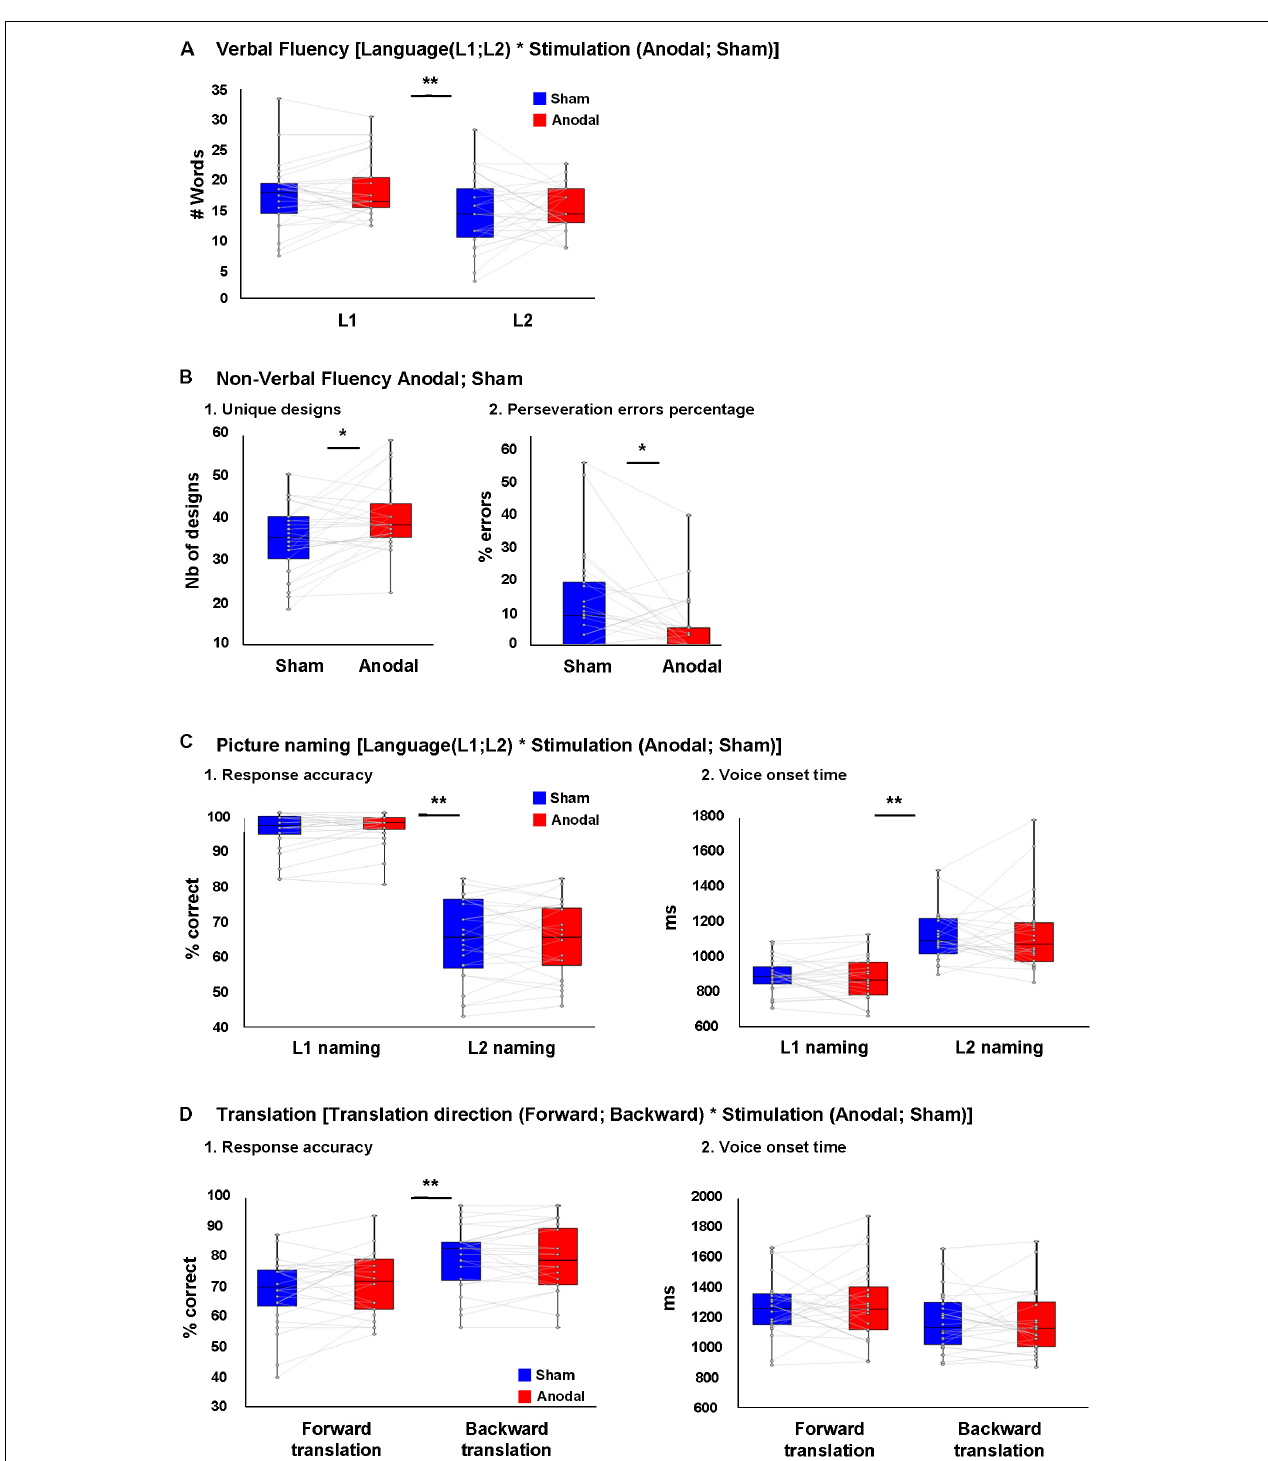
FIGURE 2 | Behavioral results. (A) No difference was seen between the number of L1 and L2 words produced during verbal fluency task during anodal or sham-tDCS. (B) (1) Higher number of unique designs produced and (B) (2) less perseveration error percentages in non-verbal fluency task during anodal-tDCS. (C) (1) Response accuracy and (C) (2) voice onset time (VOT) in L1 and L2 picture naming following anodal or sham-tDCS showed a main effect of Language (better performance in L1), while no interaction between Language and Stimulation was seen. (D) (1) Response accuracy and (D) (2) VOT in forward and backward translation following anodal or sham-tDCS showed a main effect of translation direction (better performance in backward translation), while no interaction was seen between translation direction and stimulation. ∗ p < 0.05 and ∗∗ p < 0.01.